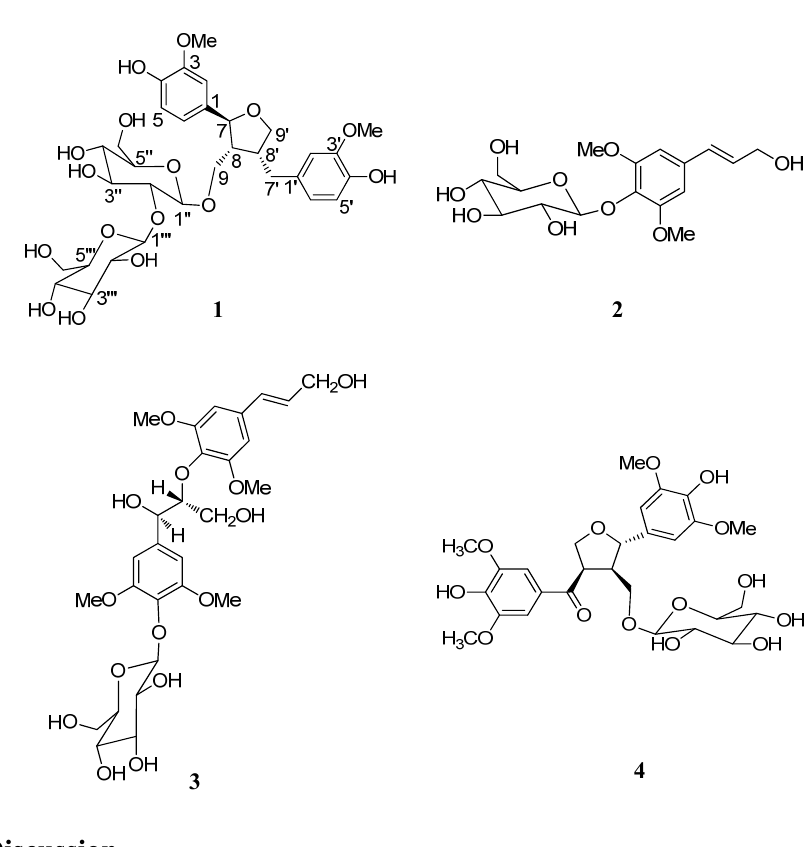
Figure 1. Structures of compounds 1 – 4